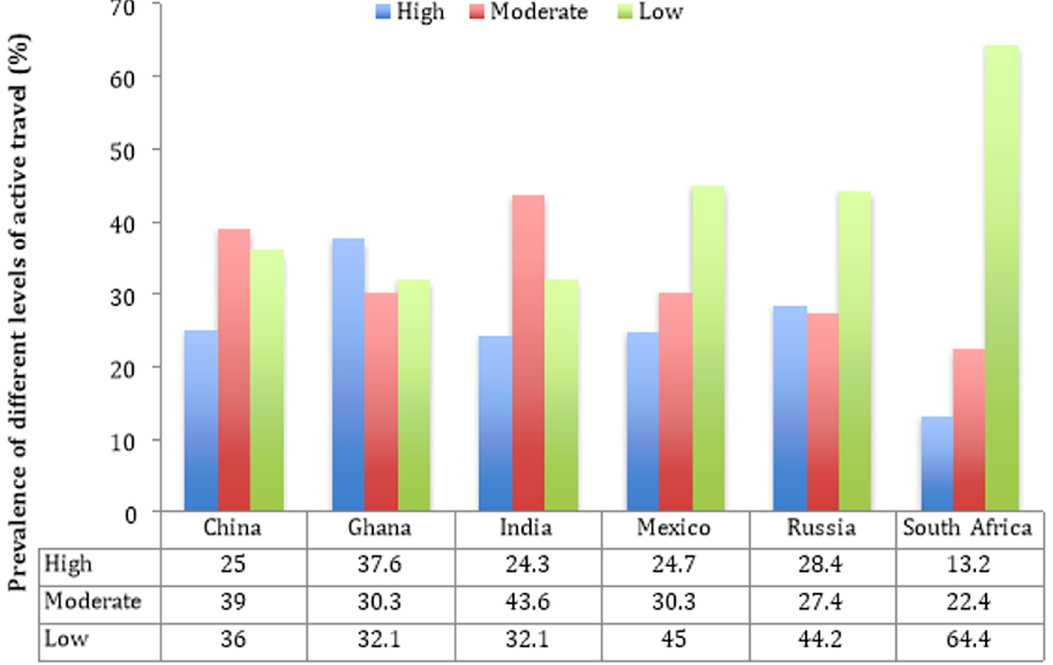
Fig 1. Prevalence of different levels of active travel by